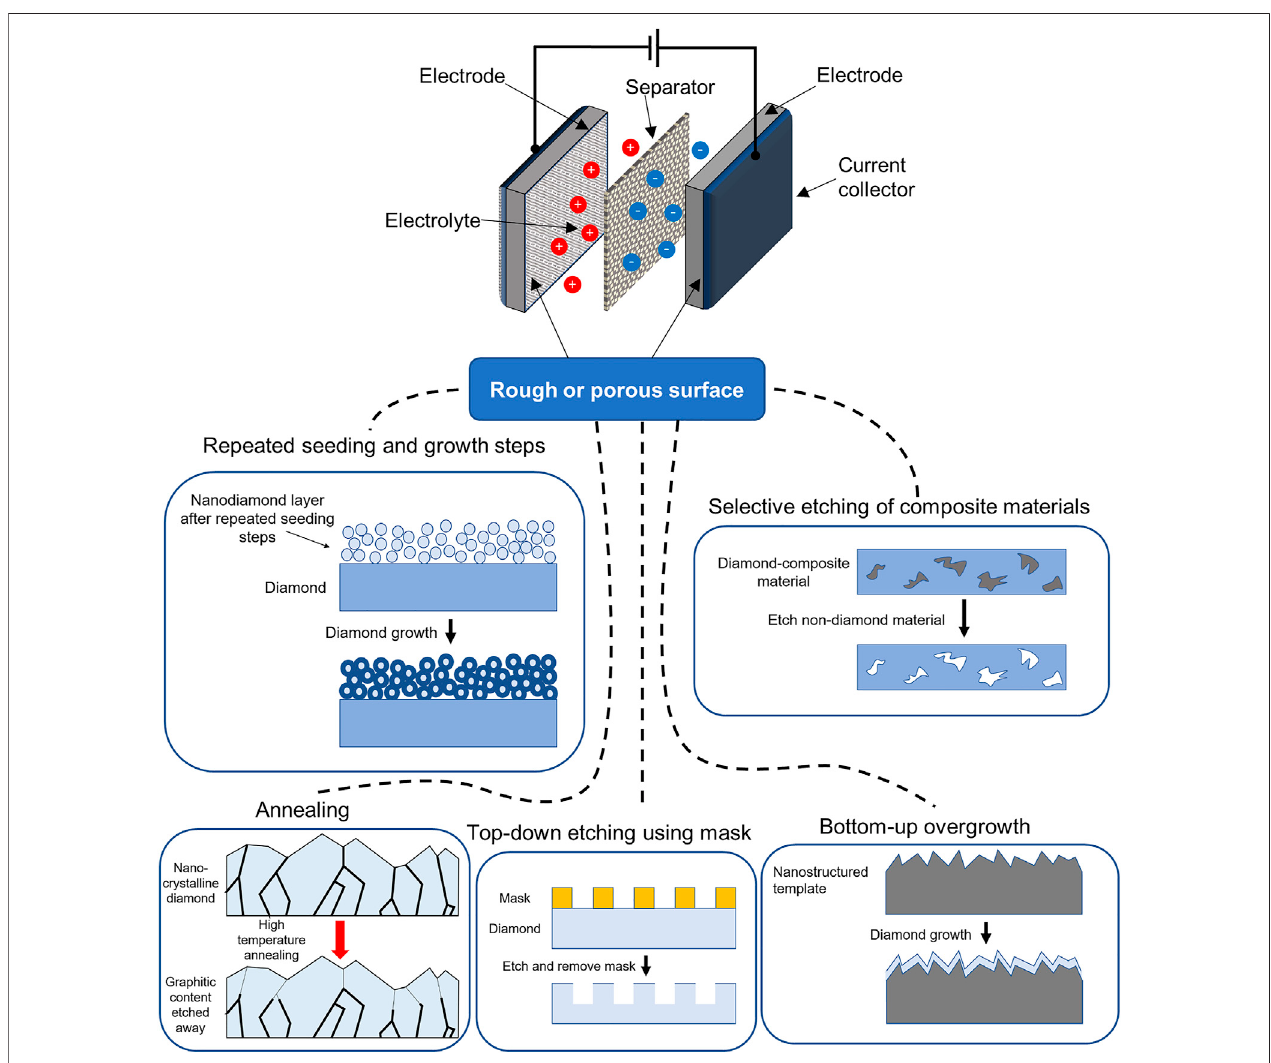
FIGURE 1 | A simpli fi ed schematic of the design of a supercapacitor, as well as different methods for creating rough or porous surfaces of diamond for supercapacitor electrodes.